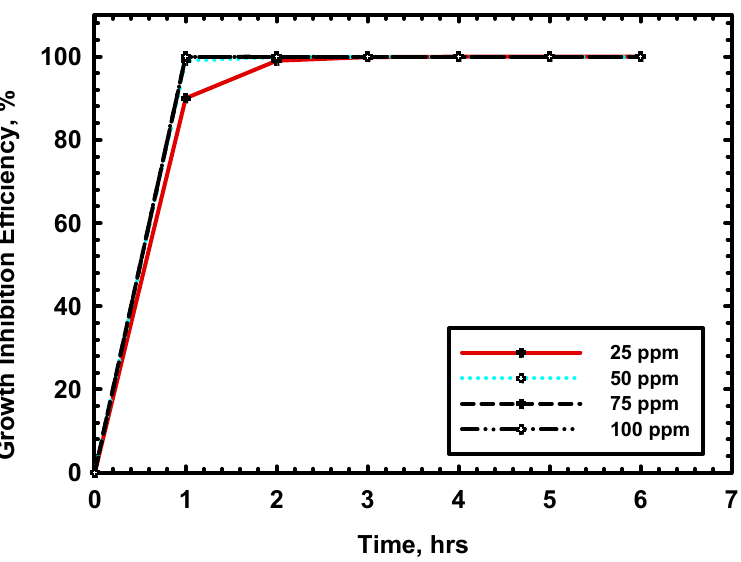
Figure 3. The inhibition efficiency of the bacterial growth in presence of different concentrations of [OH-EMIm]Cl.